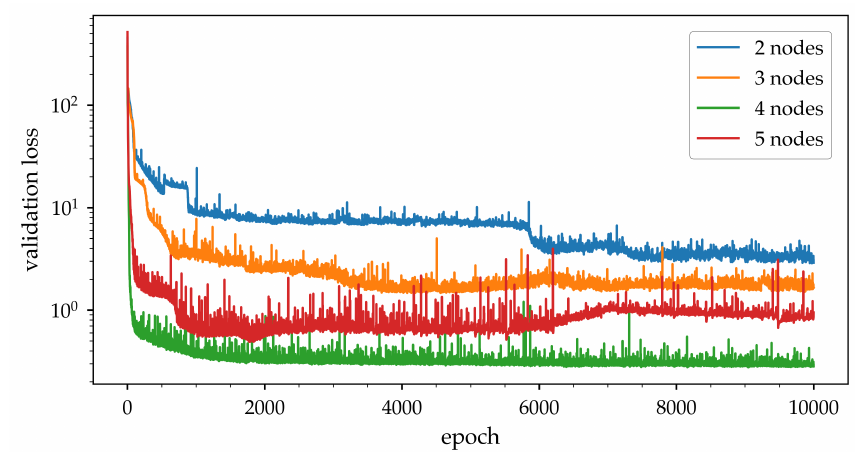
Figure 15. Loss as a function of epoch for the validation set when training on 10 weeks of data.